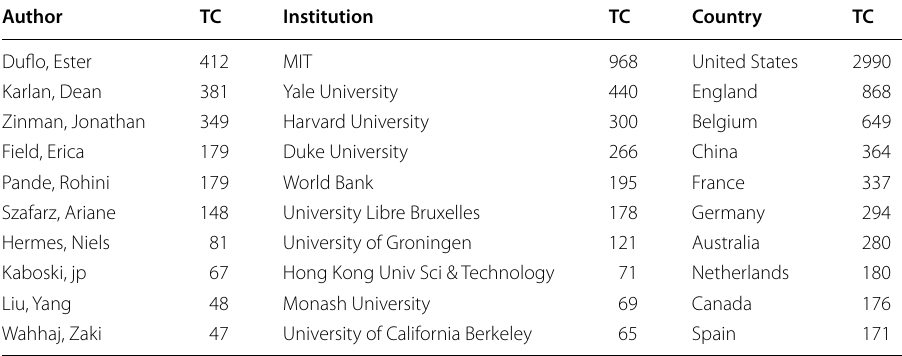
Table 5 Top authors, affiliated institutions and countries for sample statistics of 524 papers by total citations amongst the 524 published articles between 1:2012 and